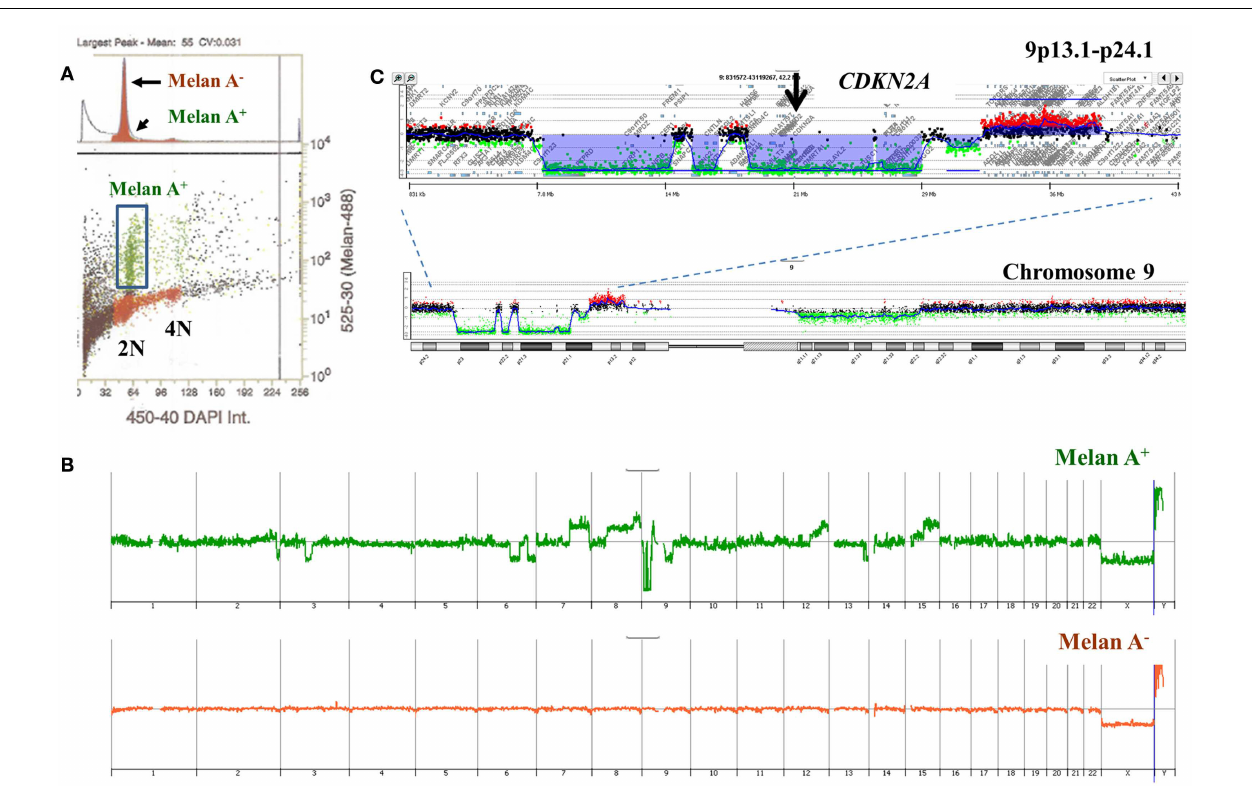
of melan A − and melan A + diploid genomes. (C) Chromosome 9 and 9p13.1-p24.1 views of homozygous deletion in diploid melan A + genome. Blue shaded area denotes ADM2 defined aberrant